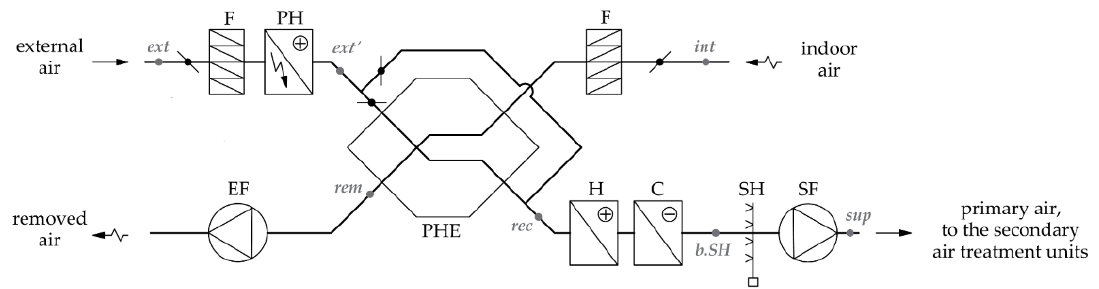
Figure 4. Air treatment system configuration (F, filter; PH, preheater; PHE, plate heat exchanger; H, heater; C, cooler; SH, steam humidifier; SF, supply fan; EF, exhaust fan). Table 4. Main assumptions of the air treatment system.